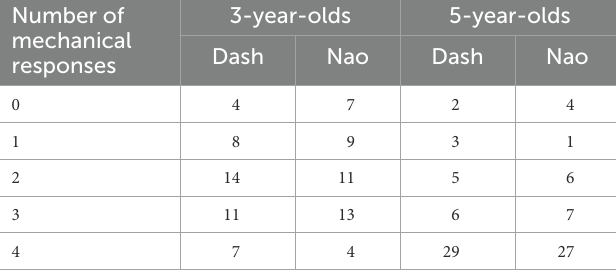
TABLE 2 Distribution of mechanical responses for Dash and Nao. Number